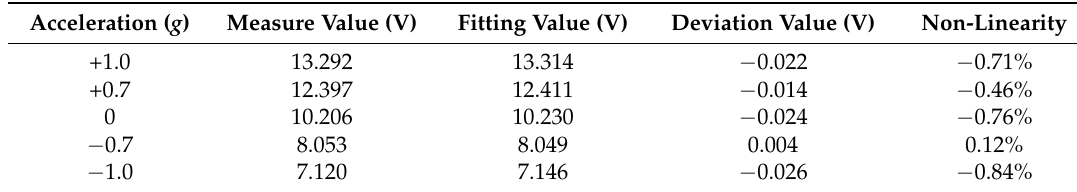
Figure 15. Noise spectrum density of the vacuum microelectronic accelerometer. The accelerometer is placed at the zero acceleration position, and the output value is measured every 0.5 h. The output value of the accelerometer is recorded in 24 h to calculate its bias stability shown in Figure 16; the result shows that the zero stability reaches 0.18 m g in 24 h.